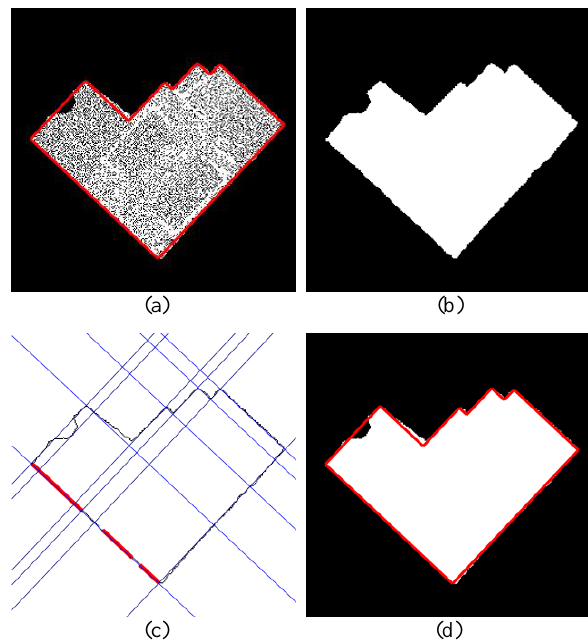
Figure 4. The results of building outline extraction obtained by the raster approach for the selected building: (a) a rasterized point cloud of the building (extraction result is shown with a red outline); (b) a building mask after morphological closing; (c) a building outline and perpendicular lines detected by Hough transform; (d) a vectorized outline.